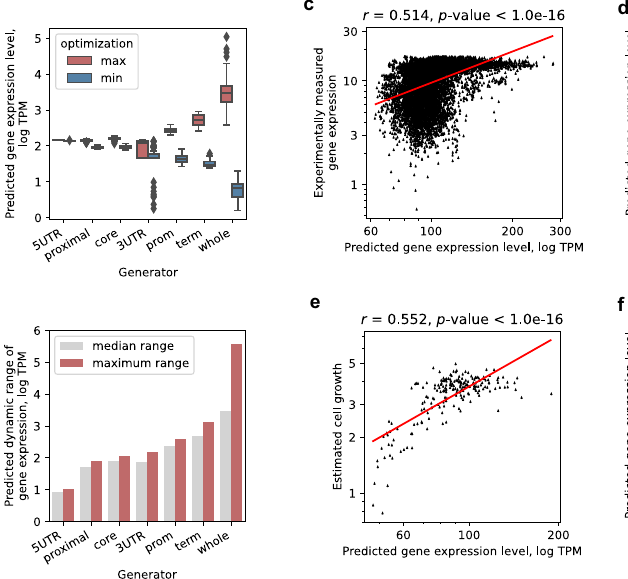
Fig. 4 | Whole gene regulatory structure unlocks a wider range of expression control than single regulatory regions. a Predicted gene expression levels with optimized generators of different single regulatory region parts or sequences spanning the whole gene regulatory structure ( n =64 per speci fi c generator opti- mization target sample, maximization marked red, minimization blue). Boxes denoteinterquartile(IQR)ranges,centersmarkmediansandwhiskersextendto1.5 IQR from the quartiles. b Dynamic ranges between median (gray) and extreme values (red) in the optimized sequence samples from a . c Correlation analysis between published experimentally measured gene expression levels (de fi ned medium)of80bpproximalpromotersequences( − 170to − 90relativetoTSS) 15 and our predictions ( n =10,282). Red line denotes the least-squares fi t. The T -test was used. d Increases (red) and decreases (blue) of predicted gene expression levels